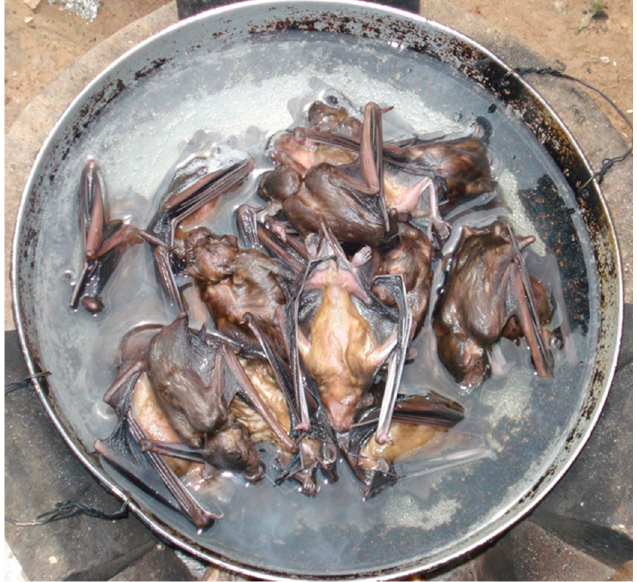
Figure 2. Bat lunch, Samraung Ta-ay, Kandal province, (T, Murphy).